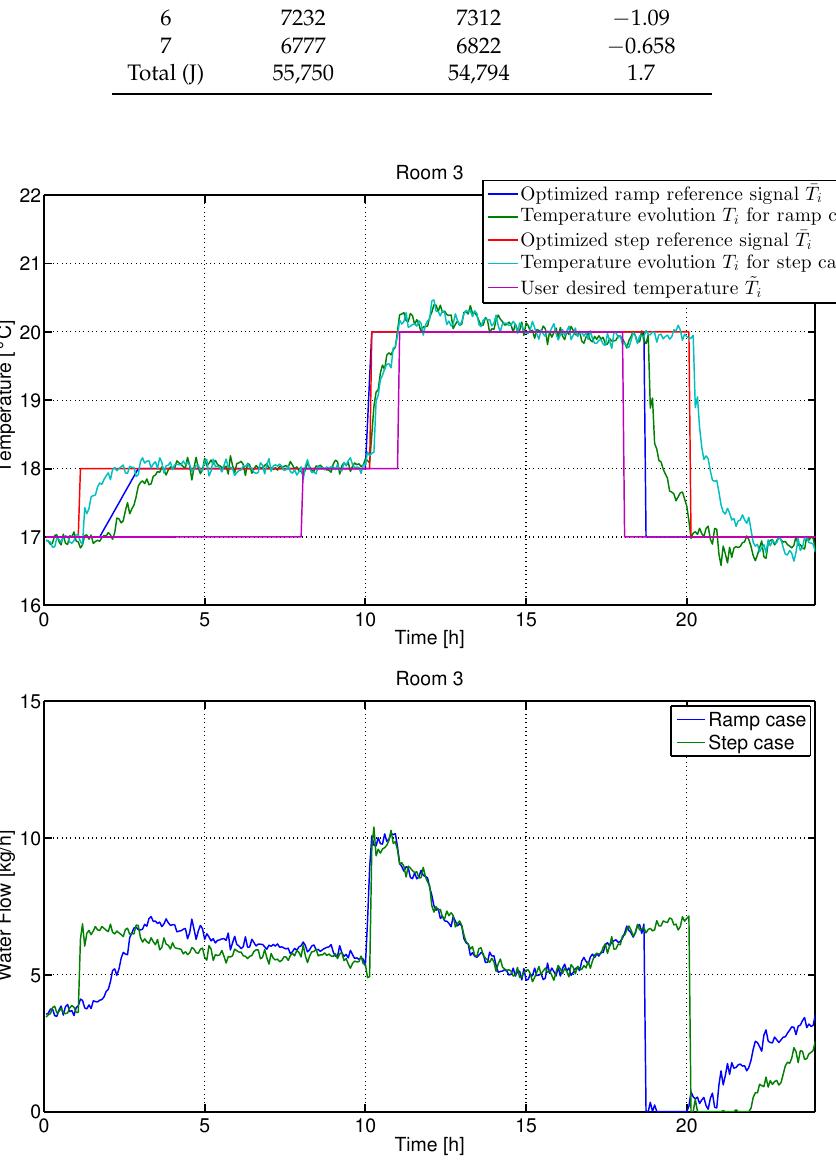
Figure 8. Results obtained by simulating the TRNSYS model of room 3 with radiators for one day, 5